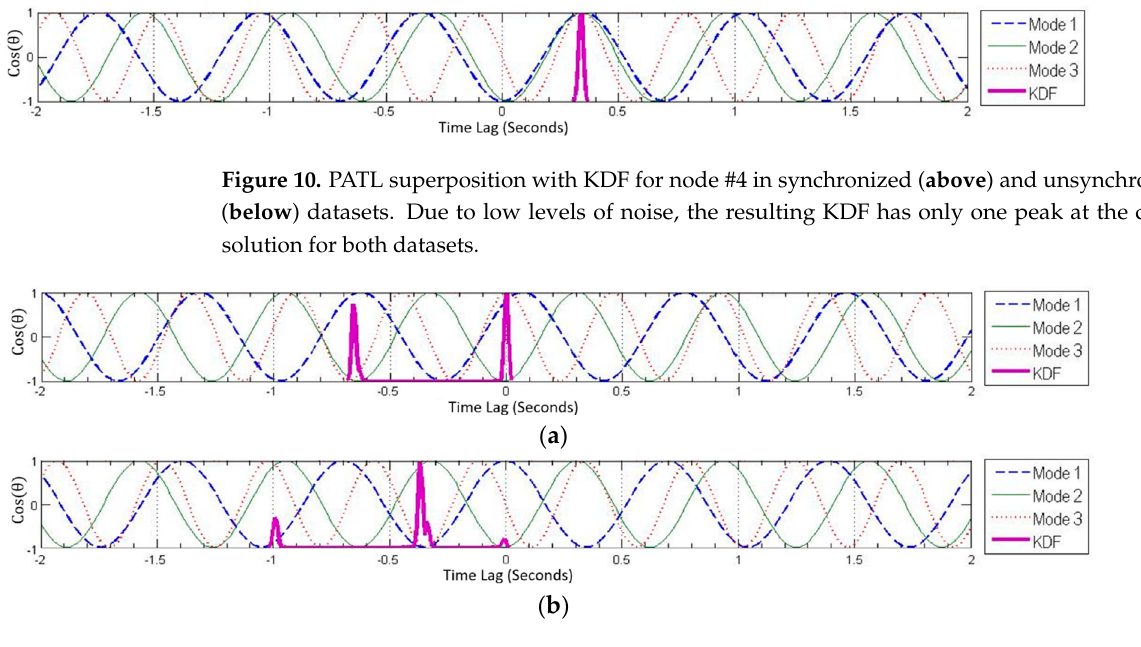
Figure 11. PATL superposition and KDF of node #26 ( a ) and node #45 ( b ) in synchronized data. In extreme cases, it is possible that some nodes may have several corrupted PATLs.